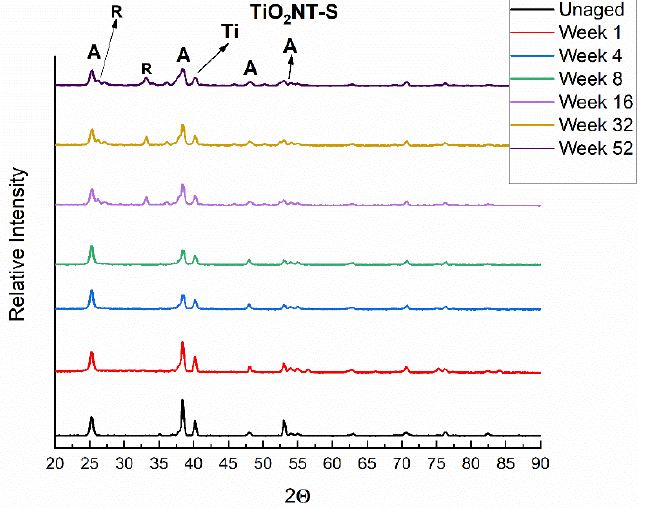
Figure 9. XRD diffraction plots of samples anodized in the aqueous electrolyte and aged for different time periods.